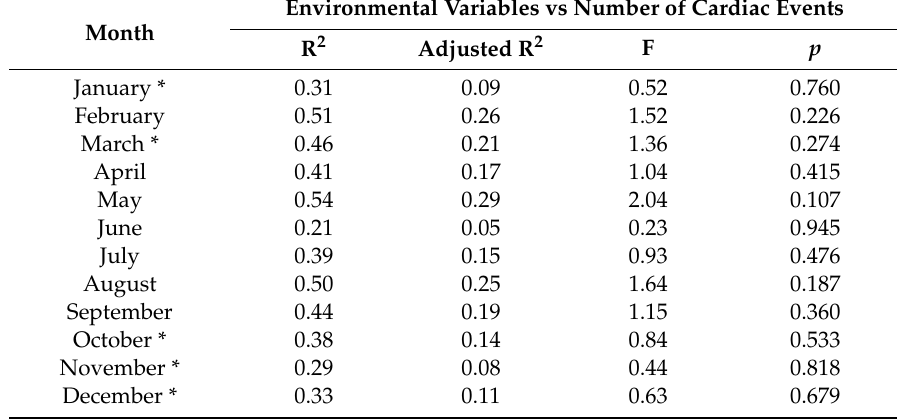
Table 10. Assessment of the number of cardiac events / number of admissions relative to the environmental variables from January 2011 to December 2011. Environmental Variables vs Number of Cardiac Events Month R 2 Adjusted R